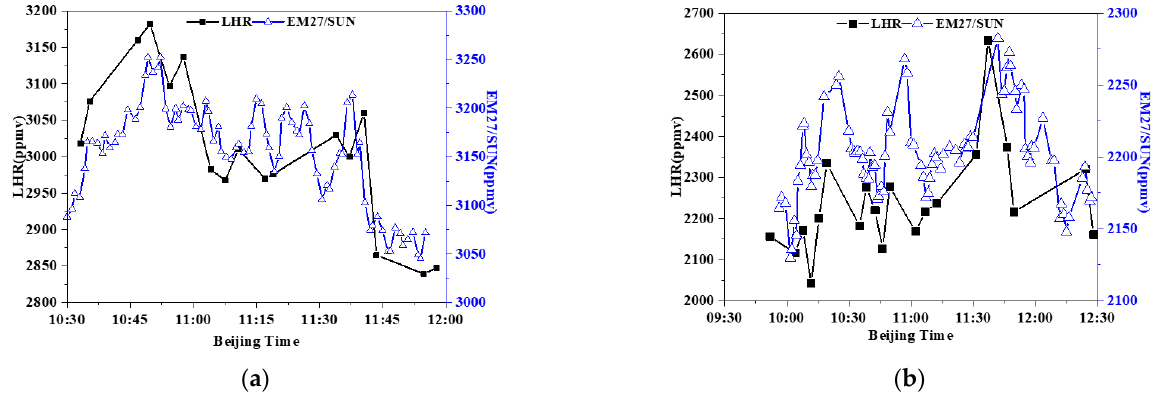
Figure 10. The water vapor column densities of EM27/SUN and LHR on ( a ) 20 and ( b ) 21 July.